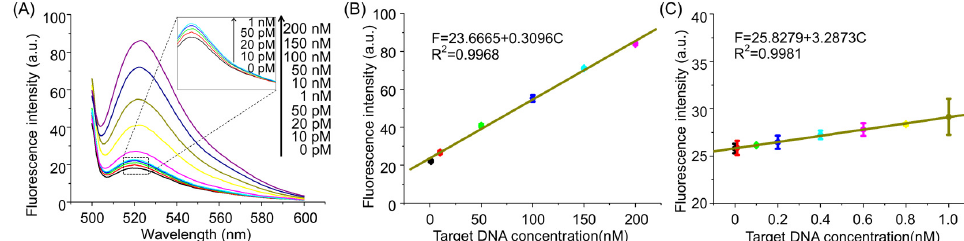
Figure 4. Quantitative detection of plant miRNA160D by AMM. ( A ) Fluorescence spectra of AMM upon the different concentrations of target DNA: 0, 0.01 nM, 0.02 nM, 0.05 nM, 1 nM, 10 nM, 30 nM, 50 nM, 80 nM, 100 nM, 150 nM, and 200 nM. Inset: Fluorescence spectra at low concentrations of miRNA160D. The calibration curves in the high concentration range ( B ) and low concentration range ( C ). The concentration of HP1, HP2, HP3, and HP4 are 250 nM, 250 nM, 250 nM, and 250 nM, respectively. The error bars represent means ± SD ( n =